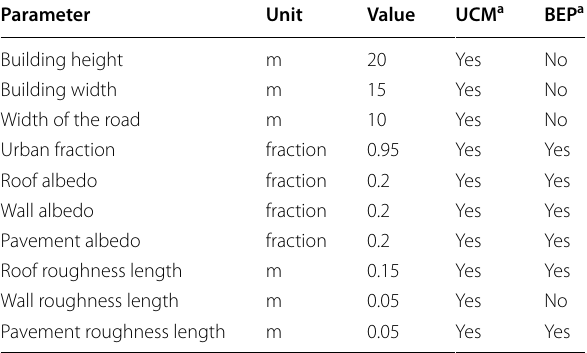
Table 3 Urban parameters for UCM and BEP schemes and their usage in the different canopy schemes